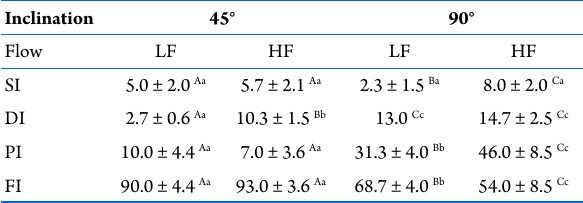
Table 1. Results of the tests carried out for the different treatments on migratory behavior bioassays of Macrobrachium tenellum juveniles.